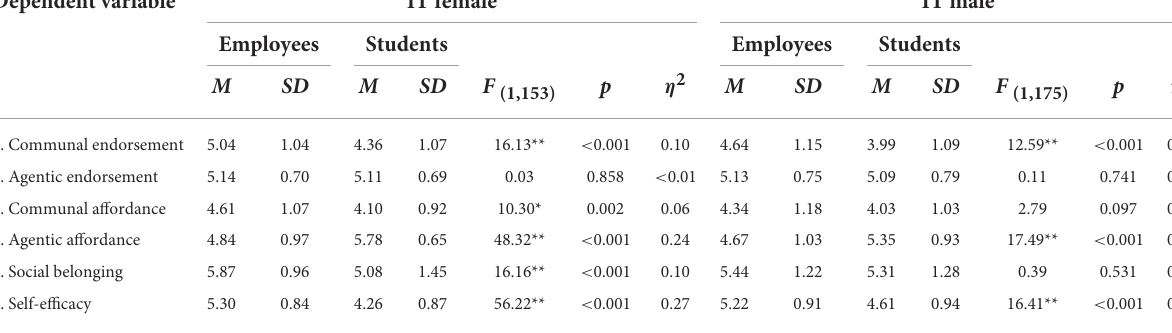
TABLE 3 Results of a series of MANOVAs showing differences between employees and students in the IT field. Dependent